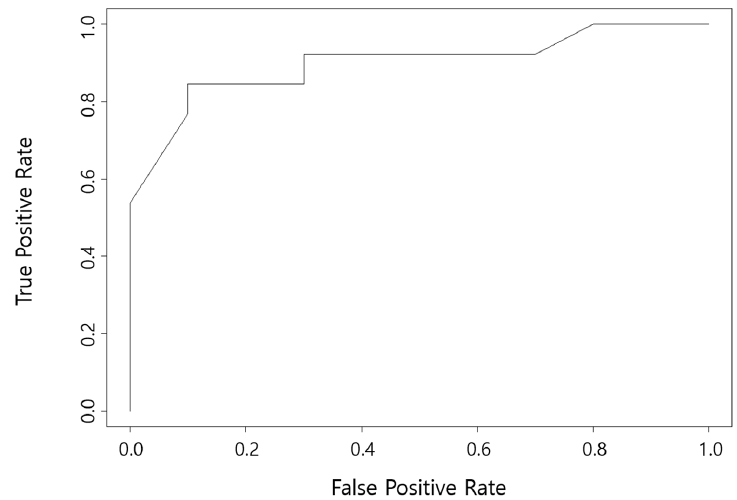
Figure 8. The results of pothole classification using AUC (area under curve).